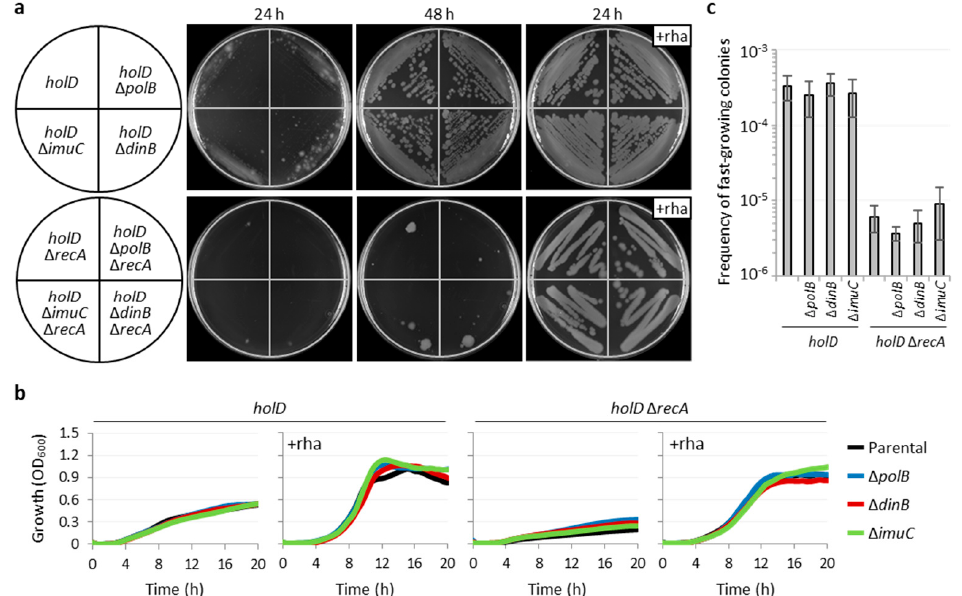
Figure 5. Specialized DNA polymerases do not account for residual growth and emergence of fast- growing variants in the holD conditional mutant. ( a ) Growth of the P . aeruginosa holD conditional mutant ( holD ), the holD ∆ recA conditional mutant and their cognate polB , dinB or imuC deletion mutants on MH agar plates after 24 and 48 h of incubation at 37 ◦ C. Images are representative of three independent assays. ( b ) Growth curves of the same strains described in panel ( a ) in MH at 37 ◦ C. Data are the mean of three independent assays. When indicated, liquid and solid media were supplemented with 0.01% rhamnose (+rha). ( c ) Frequency of fast-growing colonies obtained on MH agar plates without rhamnose for the same strains described in panels ( a , b ). Data are the mean ( ± SD) of five independent assays.